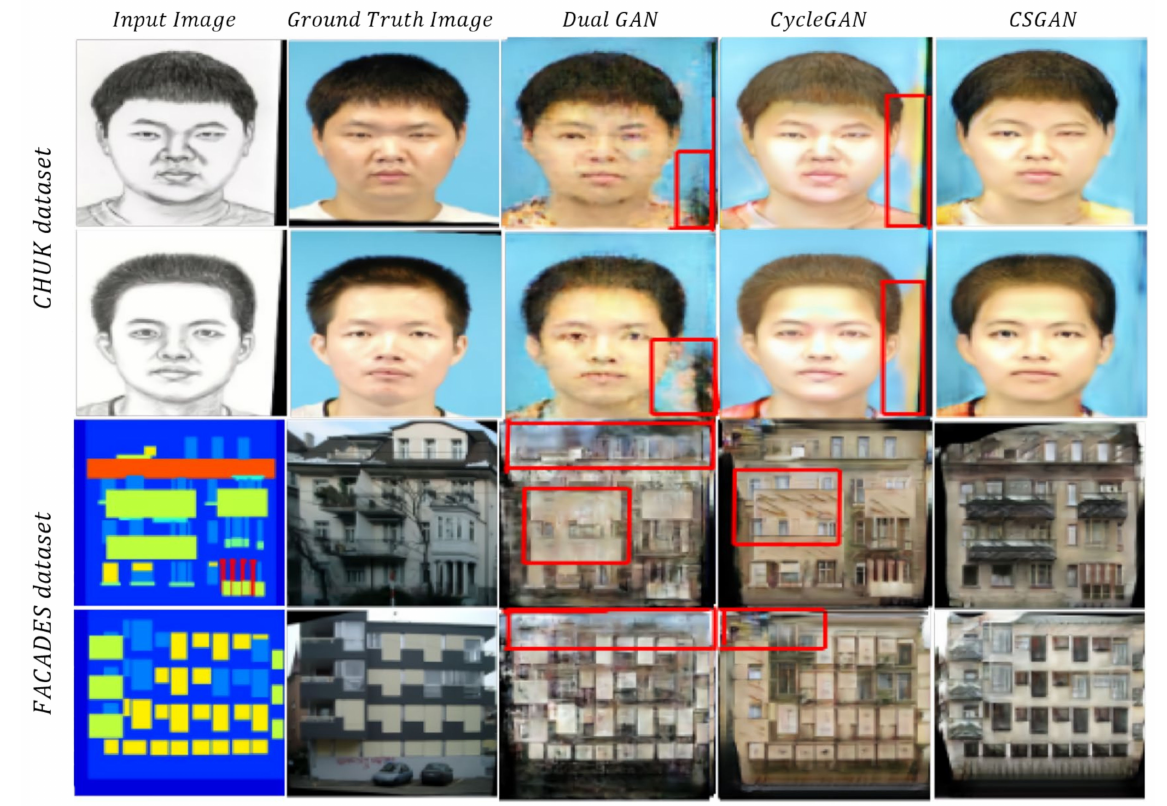
Figure 23. Example of image translation in CSGAN (Cyclic-Synthesized Generative Adversarial Networks)